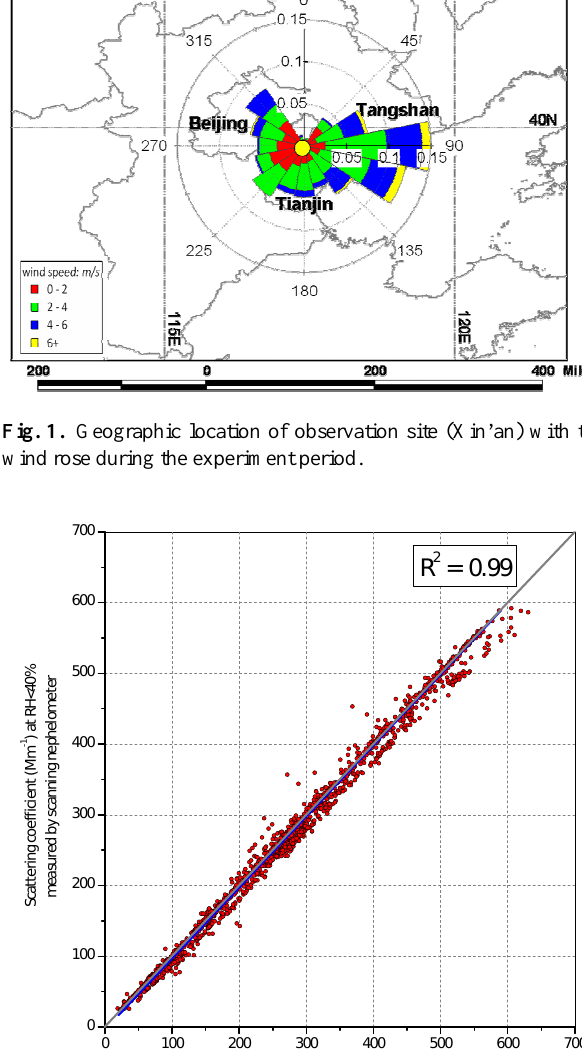
Fig.2. Comparison of scattering coefficient measured by both reference nephelometer and scanning-RH nephelometer at RH<40% Fig. 2. Comparison of scattering coefficient measured by both ref- erence nephelometer and scanning-RH nephelometer at RH <